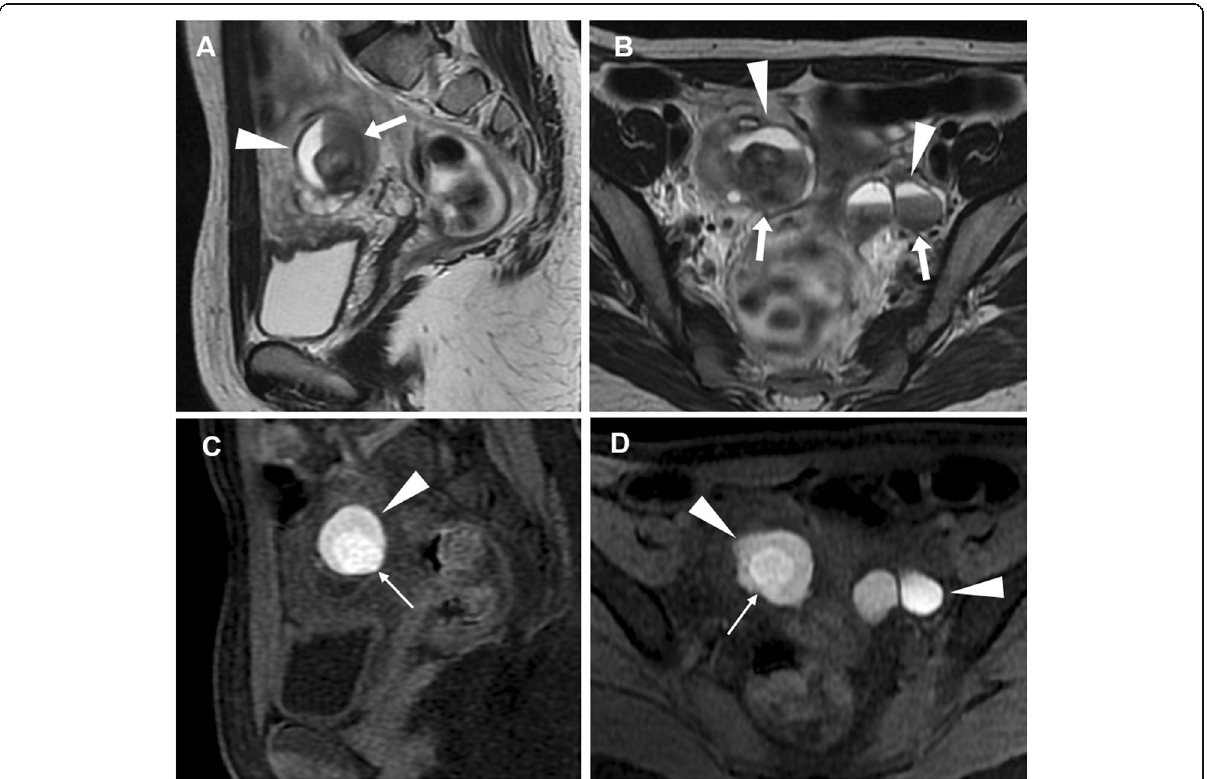
Fig. 10 MRI of bilateral endometriomas in a 27-year-old woman with pelvic pain exacerbated in the last few days. Sagittal ( a ) and oblique- coronal ( b ) T2-weighted images show bilateral endometriomas with fluid-blood levels (arrowheads) and low signal intensity in the declivous portion of the cyst ( ‘ shading sign ’ , arrows). On sagittal ( c ) and oblique-coronal ( d ) precontrast fat-suppressed T1-weighted images, the cysts demonstrate high signal intensity (arrowheads). Note the clot within right endometrioma with very high T1 signal intensity (thin